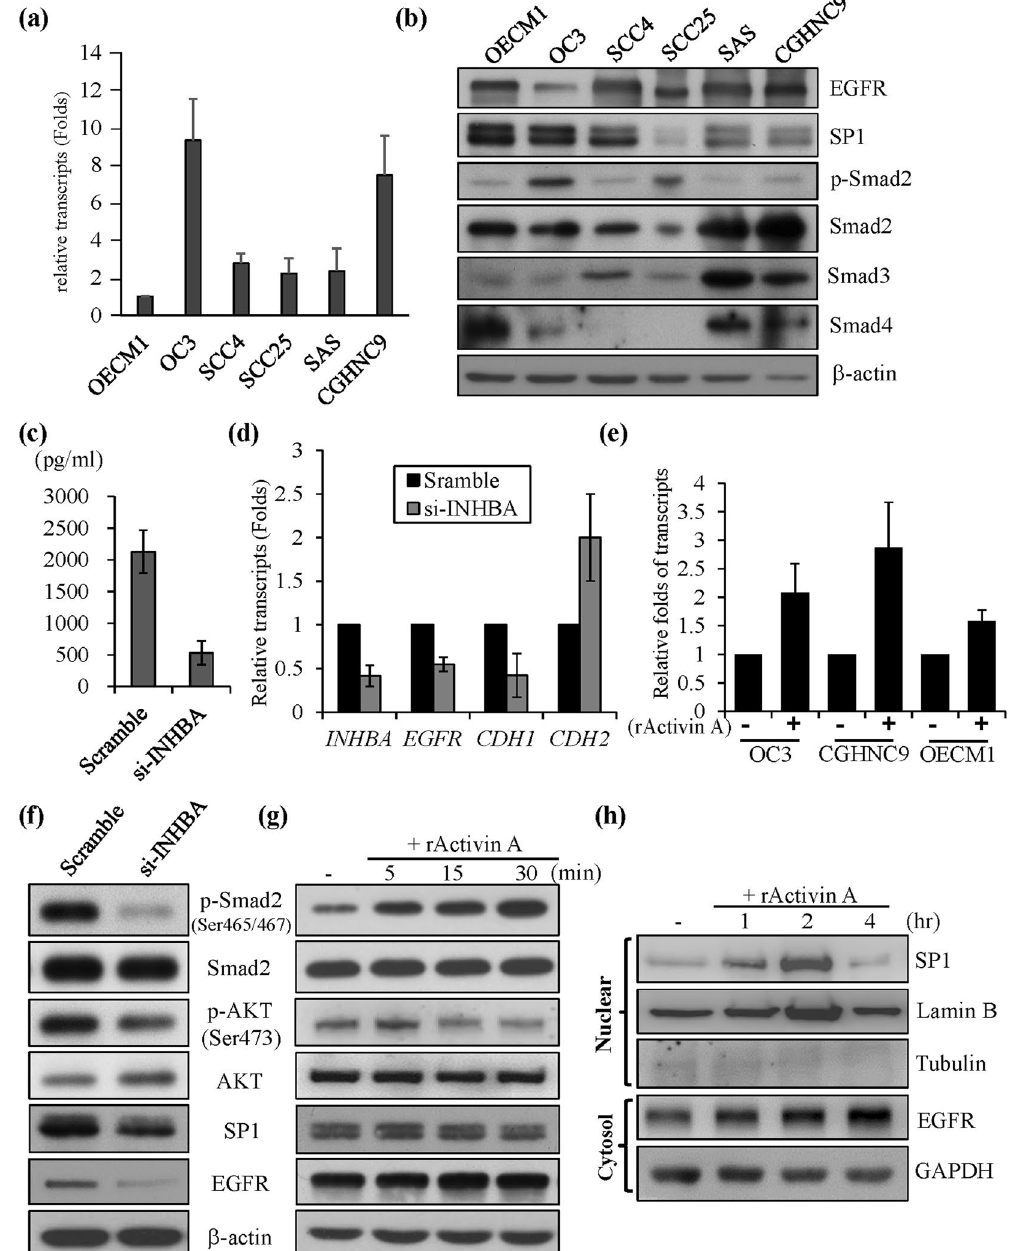
Figure 3. Knockdown of the endogenous expression of INHBA using RNAi abolished p-Smad2, attenuated p-AKT ser473, and repressed the expression of SP1 and EGFR in OSCC cell lines. ( a ) Transcripts of INHBA were measured by performing qRT-PCR using a specific primer/probe set and normalized to the expression level of GAPDH . Transcripts of INHBA in OECM1 cells were considered onefold (1X), and the relative folds of the INHBA transcripts were estimated in comparison to the endogenous INHBA level in OECM1 cells. ( b ) Protein expression of EGFR, SP1, p-Smad2, Smad2, Smad3, and Smad4 was analyzed in six OSCC cell lines via western blotting. ( c ) Secreted activin A protein levels in the supernatants of scramble- or si- INHBA -transfected OC3 cells were measured using a specific ELISA kit (R&D). ( d ) Transcripts of INHBA , EGFR , SP1 , CDH1 and CDH2 were determined by performing qRT-PCR using specific primers/probes and normalized to the expression level of GAPDH either in the scramble- or si- INHBA -transfected OC3 cells. The expression level of each gene was considered onefold in scramble control cells, and the relative expression fold of each gene was normalized to that of the scramble control cells. ( e ) Transcripts of EGFR in OC3, OECM1, and SAS cells were determined by performing qRT-PCR using specific primers/probes, and the data were normalized to the expression of GAPDH . Each cell group without rActivin A treatment was considered onefold. ( f ) The expression of p-Smad2/Smad2, p-AKT (ser473)/total AKT, SP1 and EGFR in OC3 cells transfected with Scramble/si- INHBA was examined by western blotting. ( g ) OC3 cells were exogenously treated with/without rActivin A for various times, followed by western blot analysis to detect p-Smad2/Smad2, p-AKT/AKT, SP1 and